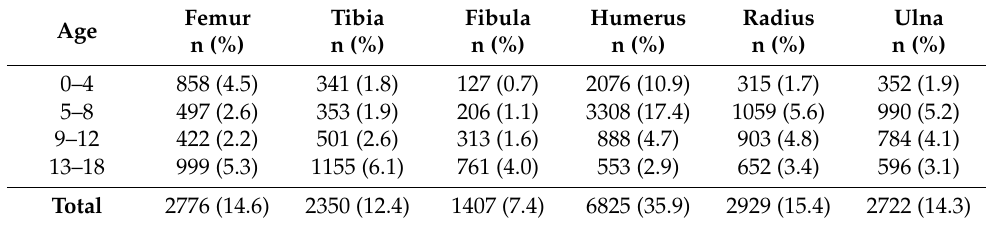
Table 2. Nonphyseal fractures for females according to age and long bone. N =